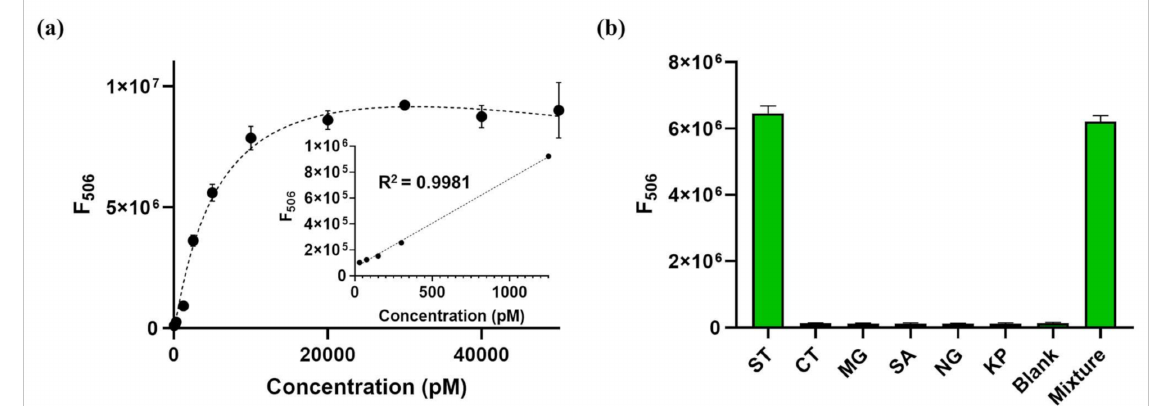
Figure 5. Detection performance of the new detection system. ( a ) Detection sensitivity of the new detection system. Inset shows the linear range between fluorescence intensity at 506 nm (F 506 ) and target nucleic acid concentration (0–1250 pM). ( b ) Detection selectivity of the new detection system. The target nucleic acid is from Salmonella Typhi (ST), whereas the non-target nucleic acids are from Chlamydia trachomatis (CT), Mycoplasma genitalium (MG), Staphylococcus aureus (SA), Neisseria gonorrhoeae (NG), and Klebsiella pneumonia (KP). The final concentration of both target and non-target nucleic acids is 10 nM. All experiments were performed in triplicate.